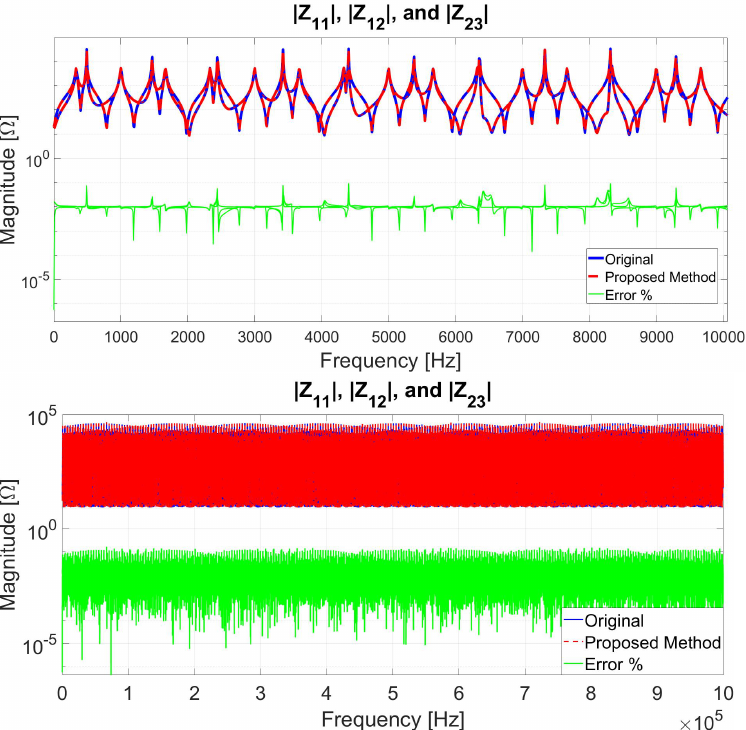
Figure 27. The magnitude of the measured and fitted impedance using the proposed model, | Z 11 | , | Z | , and | Z | 23 12